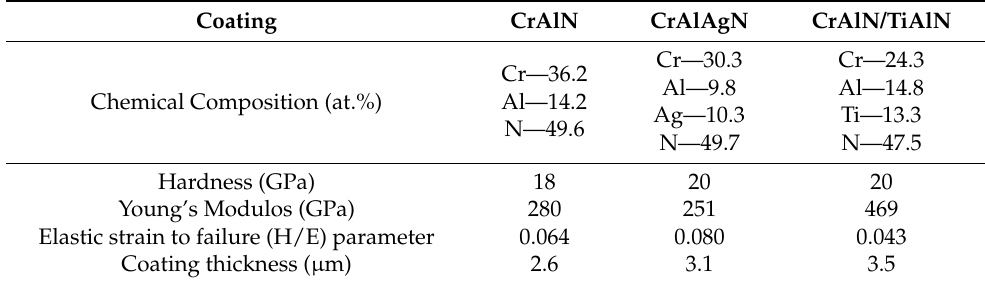
Table 4. Chemical composition, mechanical properties and thickness of the coatings.